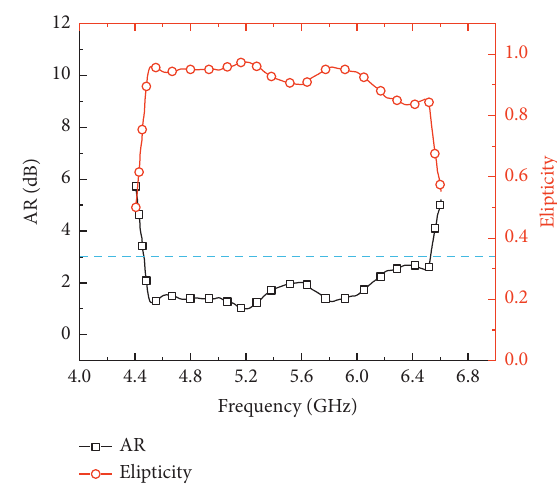
Figure 10: Simulated ellipticity and axis